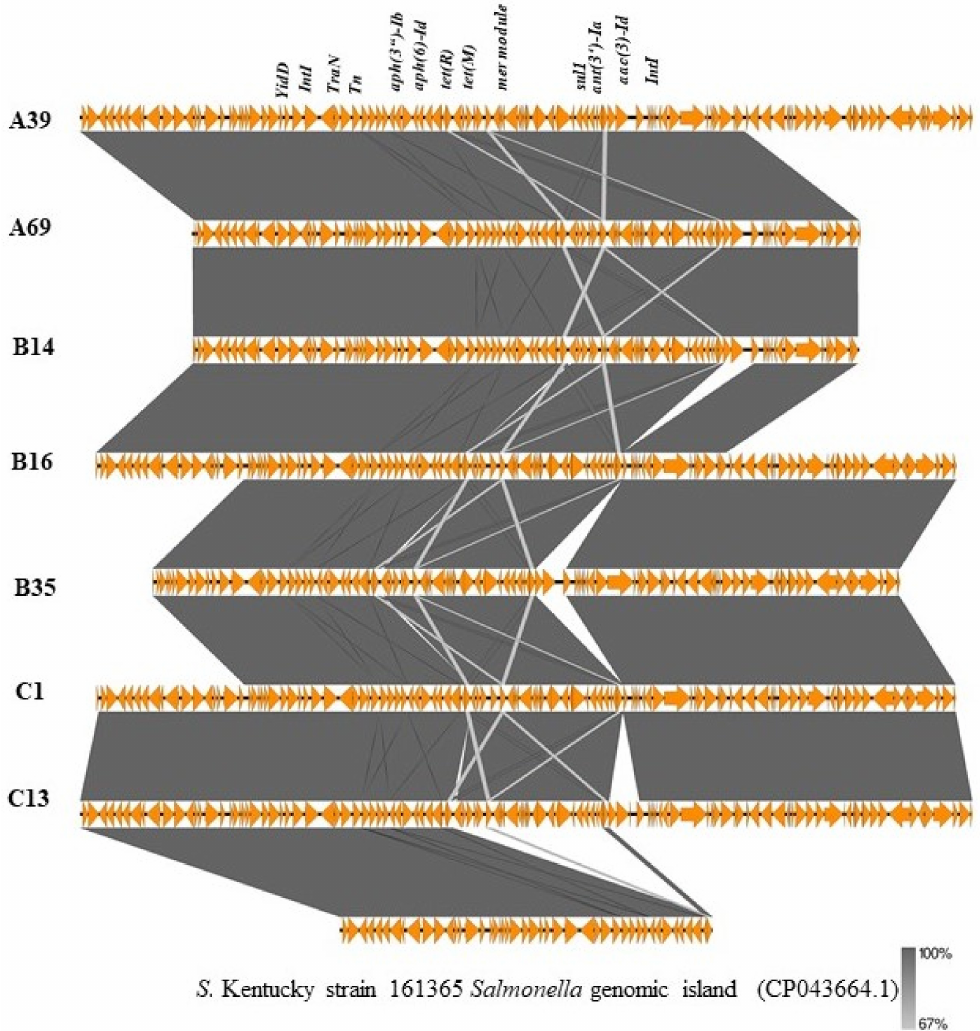
Figure 5. Alignment of 48 kb region of Salmonella genomic islands of 7 study strains (cluster II) with different variants of the SGI1-K reference sequence, created using EasyFig. Orange arrows represent coding regions of genes; blue arrows represent non-coding